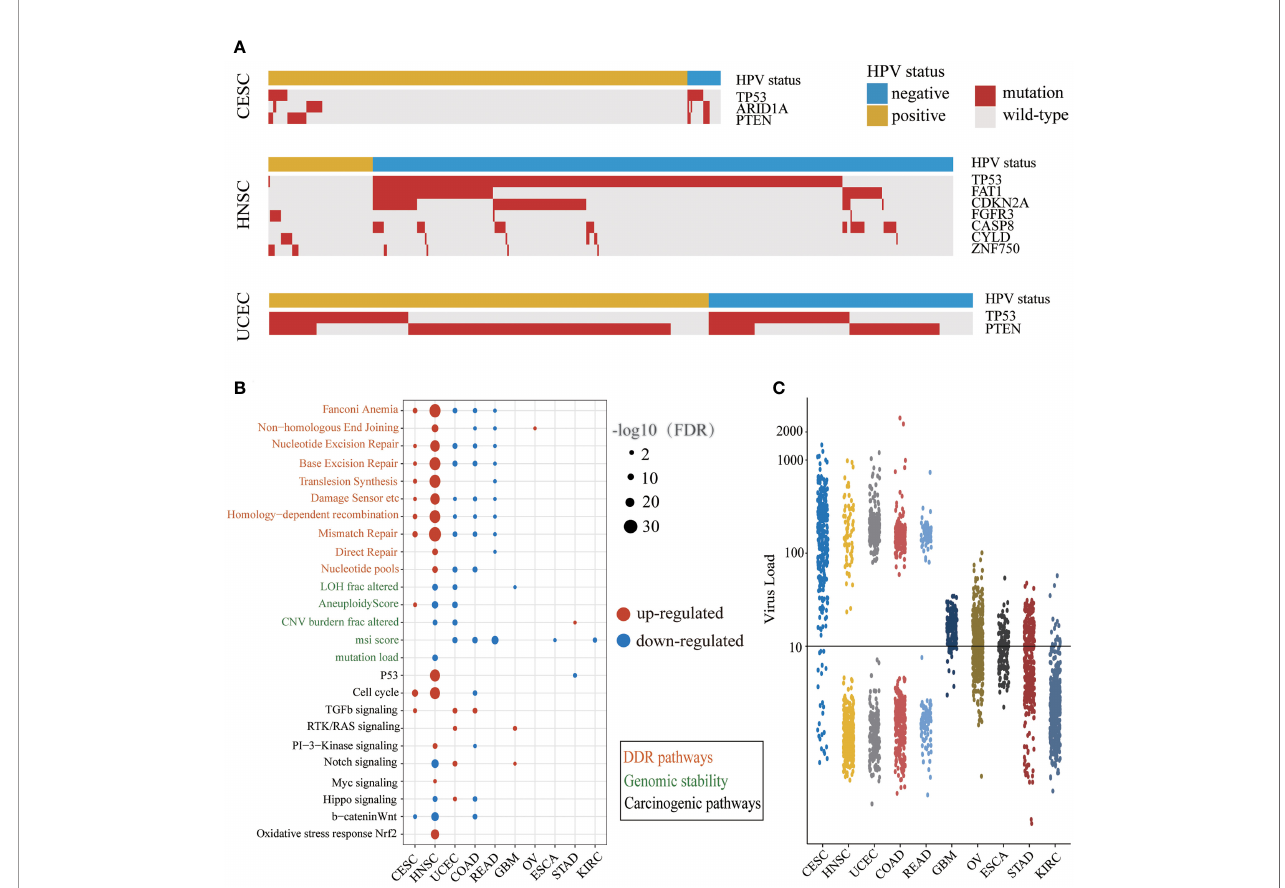
FIGURE 2 | The different carcinogenic processes between HPV-positive group and HPV-negative group. (A) A waterfall plot showing the signi fi cant differences in driver gene mutations between the HPV-positive group and HPV-negative group in three cancer types (CESC, cervical squamous cell carcinoma; HNSC, head and neck squamous cell carcinoma; UCEC, uterine corpus endometrial carcinoma). The top panel shows the HPV status of each sample. Red boxes represent gene mutation, and while gray boxes represent wild-type. (B) A bubble plot shows the signi fi cant differences of DDR (DNA damage repair) pathway activity, genomic instability indicators, and mitotic oncogenic pathway activity between the HPV-positive group and HPV-negative group. The size of the bubble represents FDR, and the color represents upregulation or downregulation. The color of the label on the Y-axis represents the different carcinogenic processes. (C) The NRPM (normalized reads per million) of HPV in different cancer types. The threshold of HPV infection was signed by a black horizontal